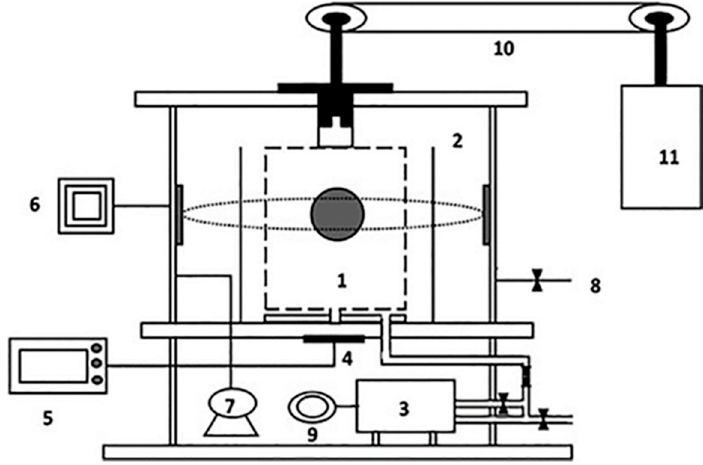
Figure 2. Schematic diagram of the microwave vacuum frying equipment: (1) Frying chamber; (2) vacuum chamber; (3) oil tank; (4) temperature sensor; (5) controller; (6) microwave source; (7) vacuum pump; (8) valve for breaking vacuum; (9) circulation pump; (10) conveyor; and (11) electric motor [84].